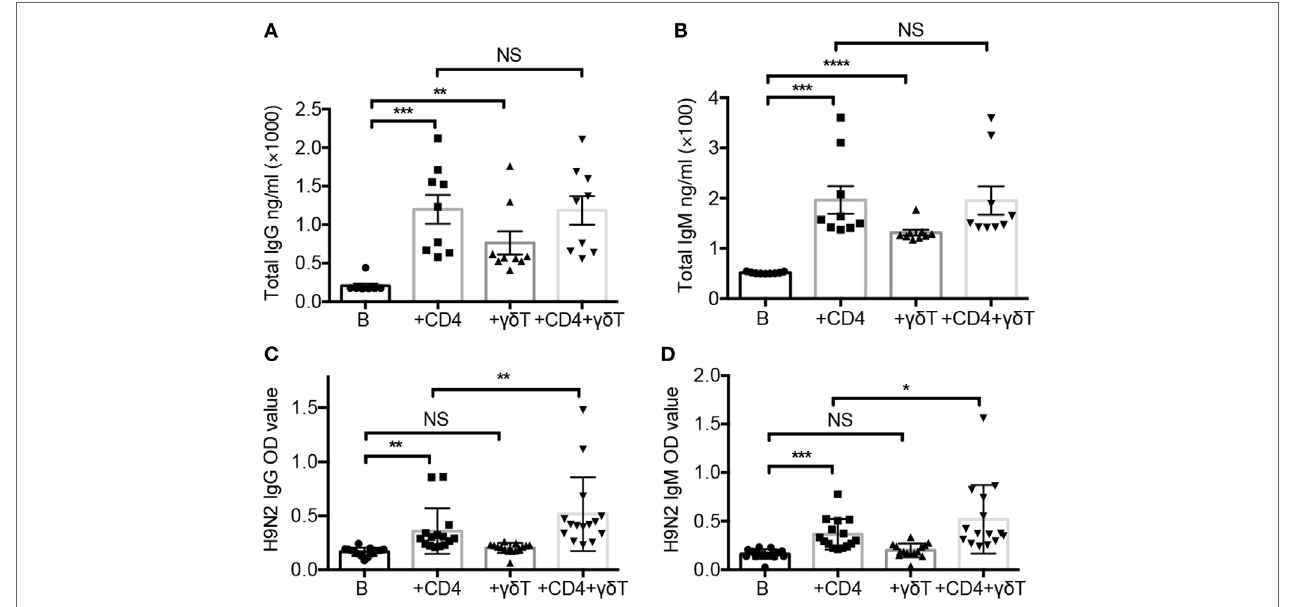
FigUre 1 | V γ 9V δ 2-T cells facilitated influenza virus-specific antibody production. Naïve CD4 T cells were cultured with UV-H9N2 virus-pulsed dendritic cells for 4–5 days, then, the activated CD4 T cells were cultured with CD19 + B cells from same donor with or without V γ 9V δ 2-T cells for another 7–10 days. (a,B) Total IgG and IgM in supernatant on day 7 were detected by enzyme-linked immunosorbent assay (ELISA). (c,D) H9N2 virus-specific IgG and IgM were detected by ELISA on day 7. Each dot means one donor. The data shown are the mean ± SEM. * p < 0.05; ** p < 0.01; *** p < 0.001; **** p < 0.0001. NS, no significant